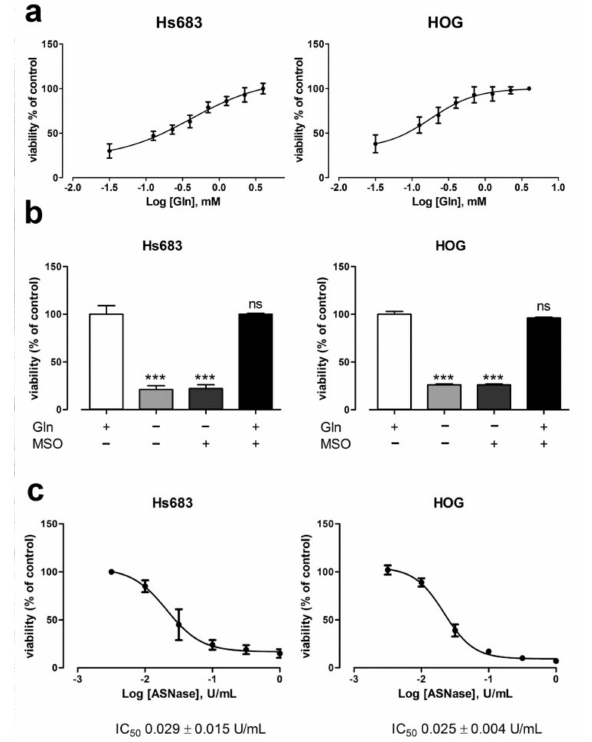
Figure 1. Glutamine Synthetase expression is negligible in human oligodendroglioma cells. ( a ) GLUL mRNA expression was assessed by real-time PCR in Hs683, HOG and U87 cells incubated in standard growth medium ([Gln] = 4 mM). Data were normalized to the expression of RPL-15 . ( b ) Western blot of GS in Hs683, HOG and U87 cells. Cells were incubated in the presence (+) or in the absence ( − ) of Gln for 19 h. β -tubulin was used for loading control. A representative experiment is